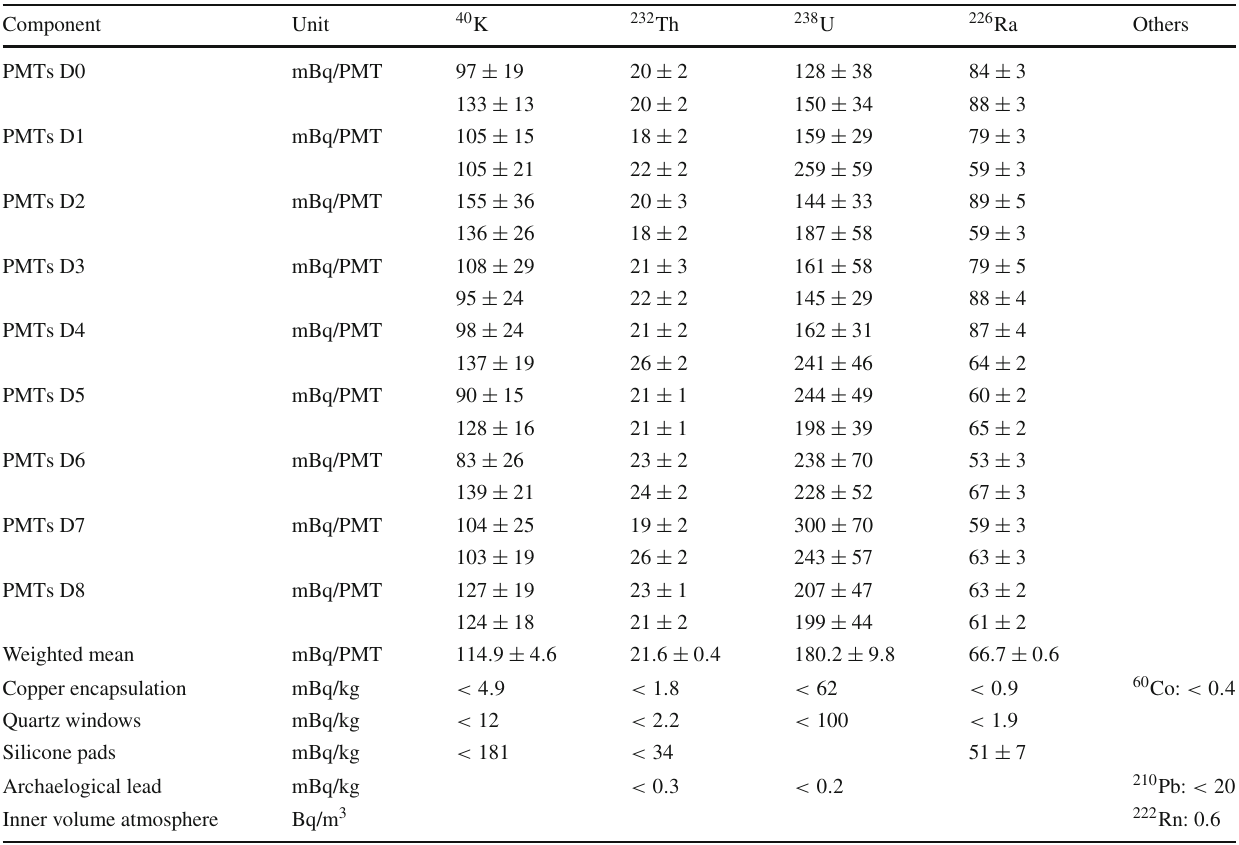
spectrometry performed at the LSC. Values obtained for each Hama- matsu R12669SEL2 PMT unit are reported together with the weighted mean for all of them. Upper limits are given at 95%